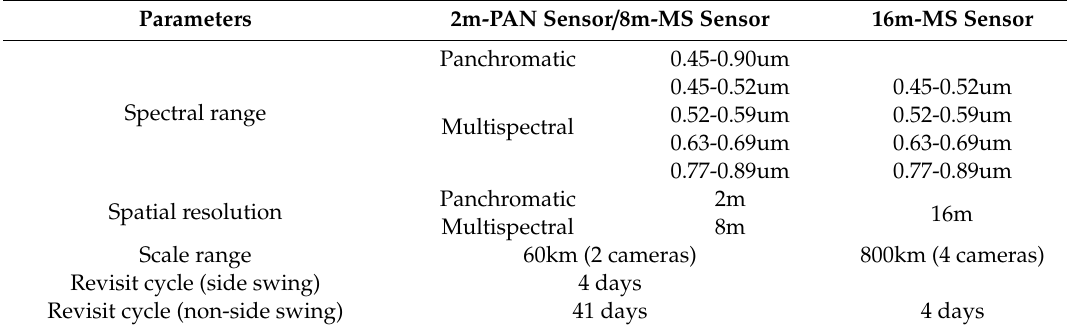
Table 2. The parameters of GF